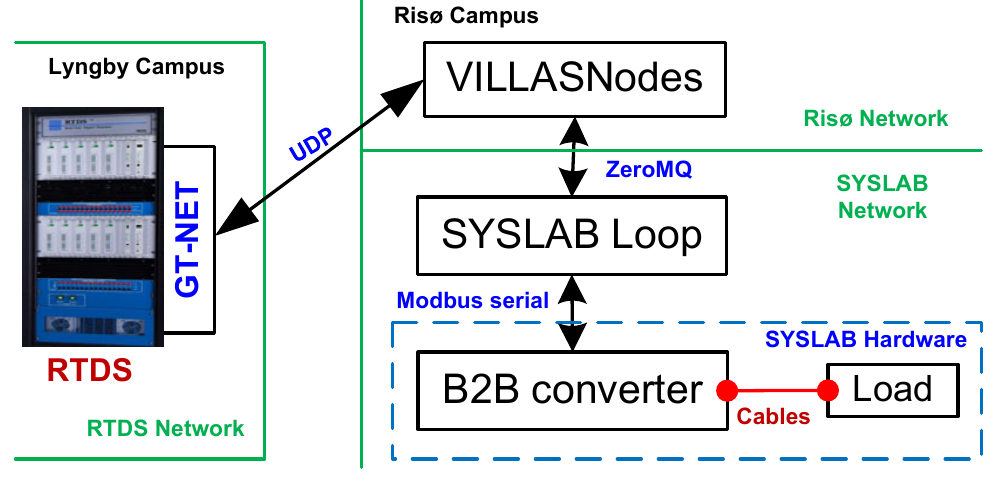
Figure 3. The PHiL setup